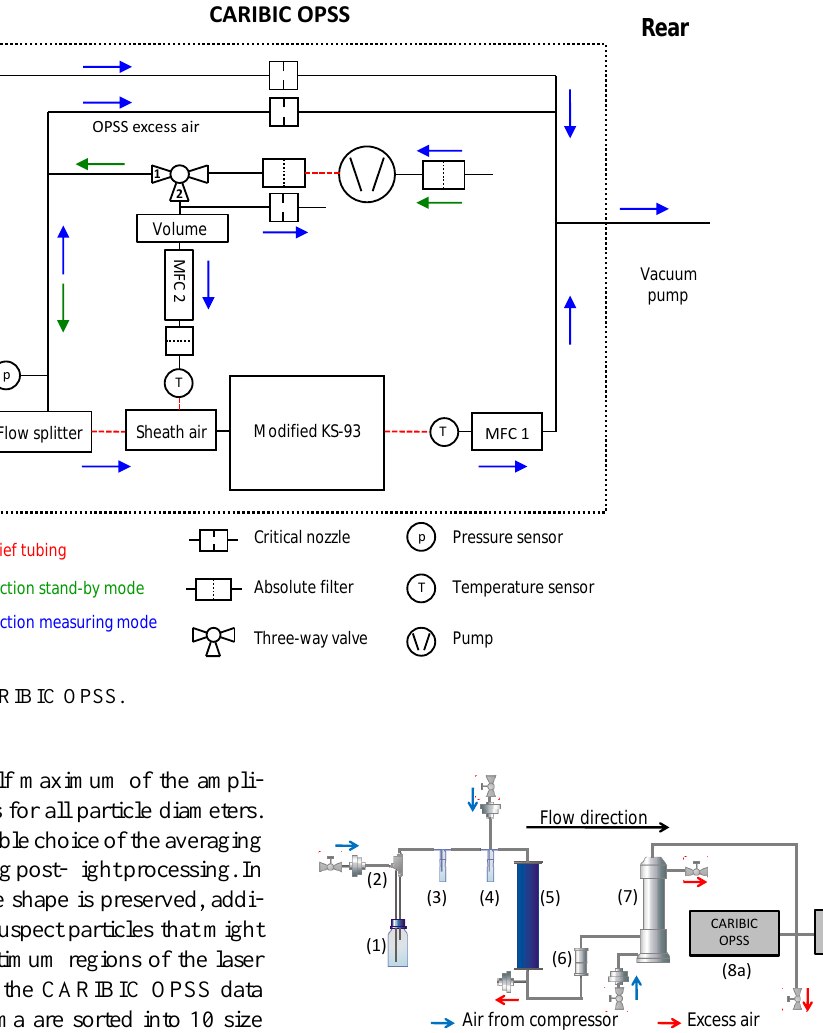
Figure 3. OPSS calibration setup with (1) glass bottle containing the particle material in aqueous solution or suspension, (2) particle generator (nebulizer), (3) droplet trap, (4) dilution unit, (5) silica gel drier, (6) bipolar diffusion charger, and (7) a differential mobil- ity analyzer. A TSI condensation particle counter (CPC 3010) was operated in parallel to the CARIBIC OPSS (8a and 8b) as reference for the counting efficiency